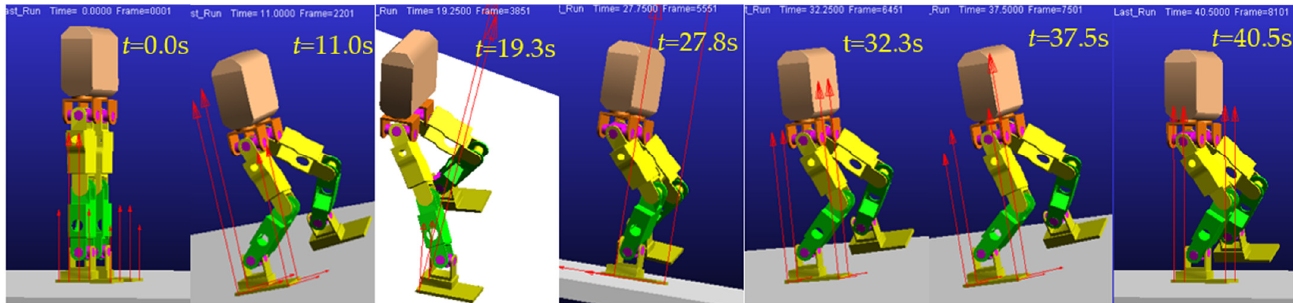
Screenshots of the single-stance stability verification simulation with impact using